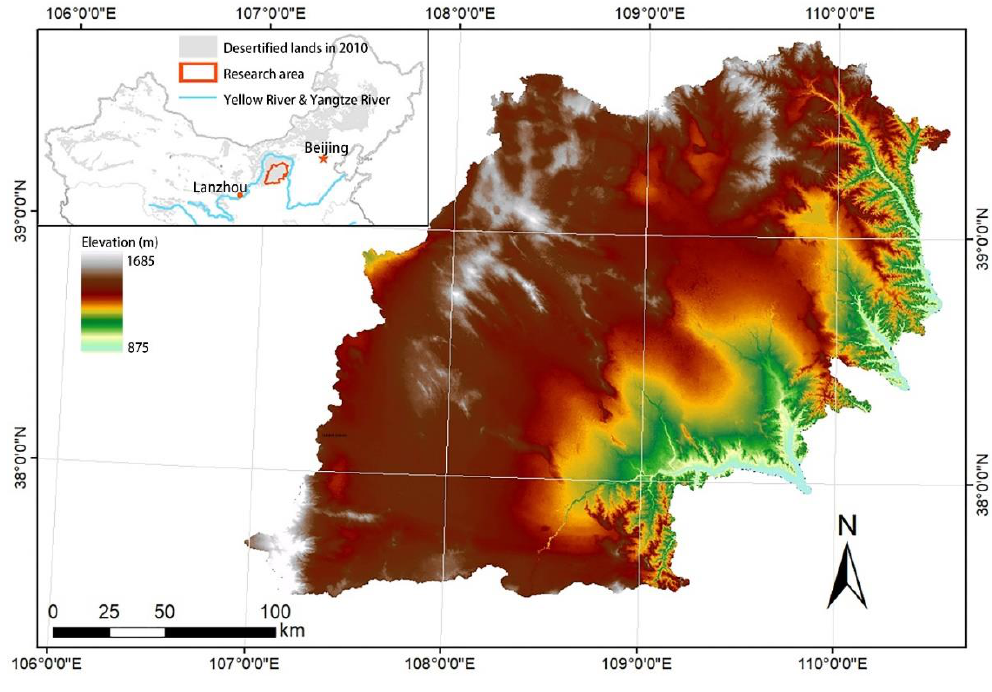
Figure 1. Elevation map of the study area.